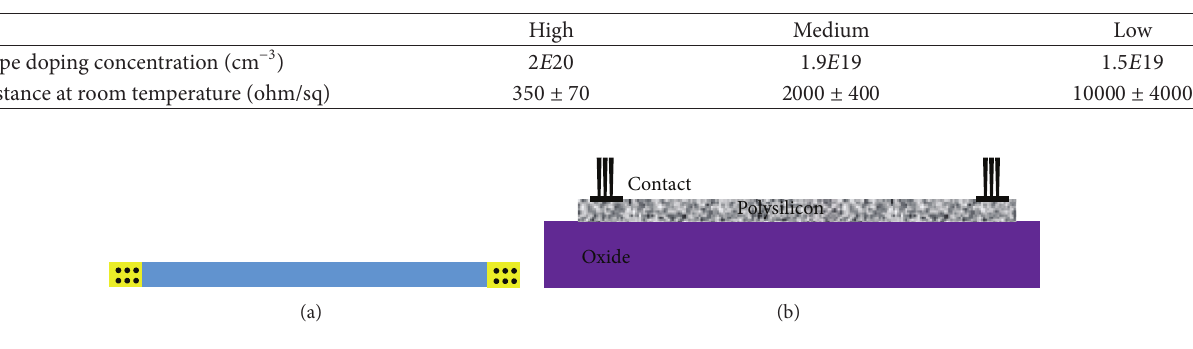
Table 1: Doping concentrations and corresponding square resistances at room temperature.